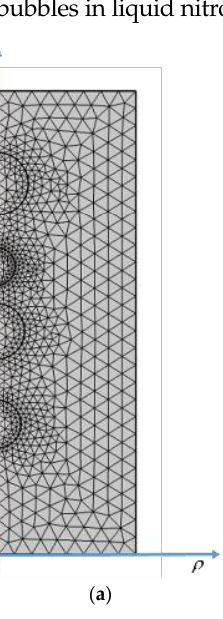
Figure 9. Meshing of the bubbles in liquid nitrogen. ( a ) CFEM, ( b ) XFEM